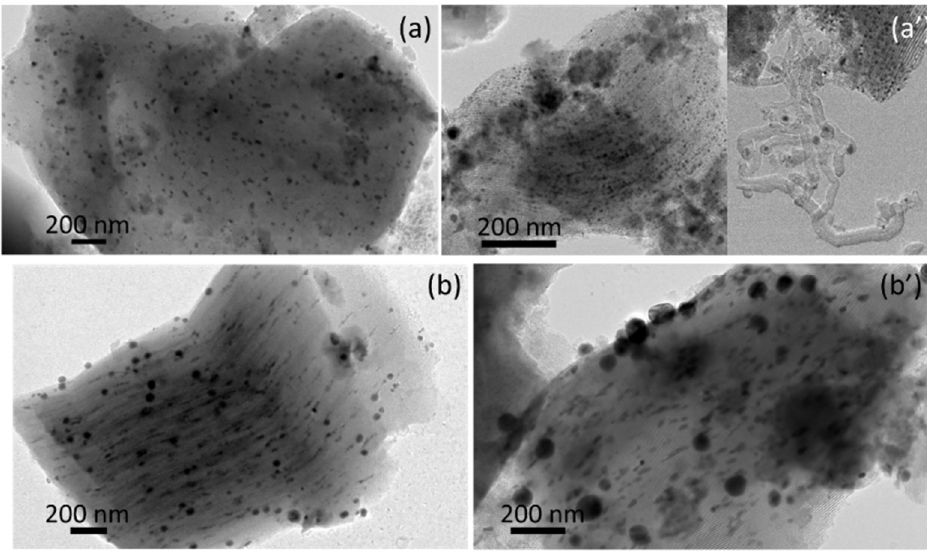
Figure 6. TEM images of ( a ) reduced Ni/SBA-15 HT (N), ( a’ ) spent Ni/SBA-15 HT (N), ( b ) reduced Ni/SBA-15 HT (Cl), and ( b’ ) spent Ni/SBA-15 HT (Cl). Ni/SBA-15 HT (Cl), and ( b’ ) spent Ni/SBA-15 HT